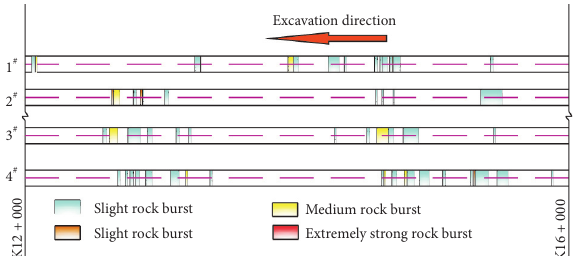
Figure 10: Rock bursts statistics during the excavation of 1 # ∼ 4 # diversion tunnels between the sections of k12 +000 ∼ k16+000.